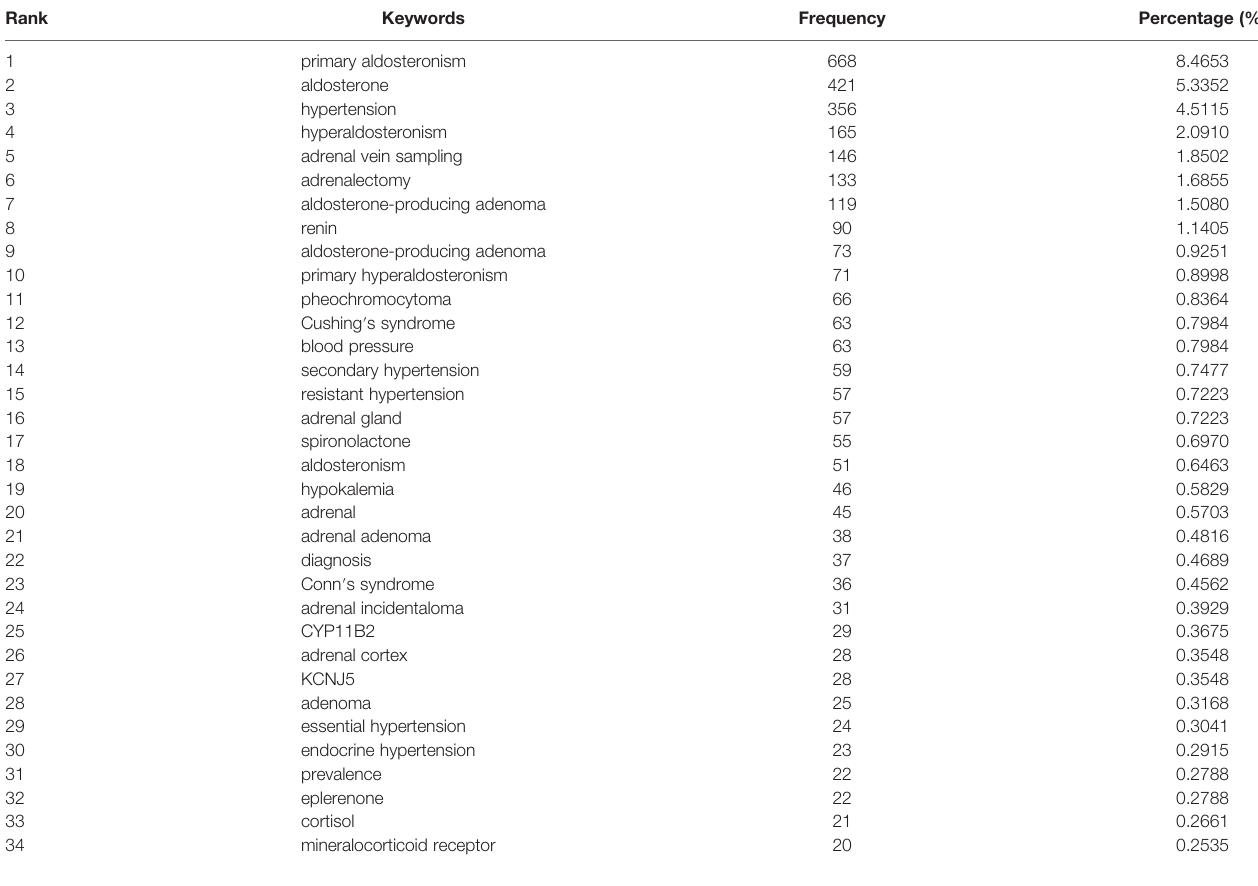
TABLE 6 | Keywords of PA research